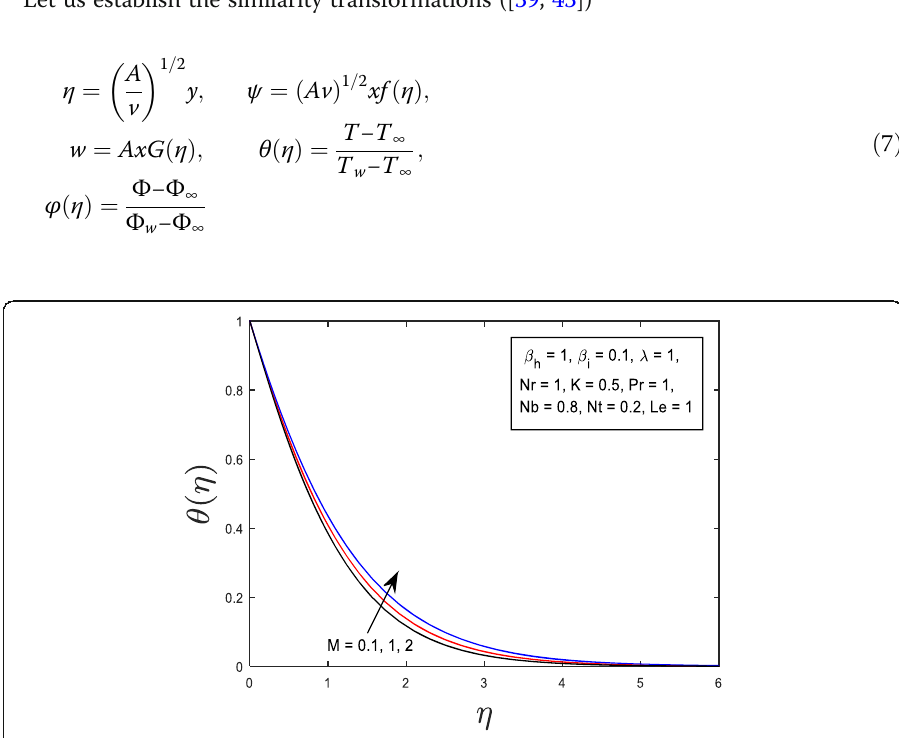
Fig. 4 Graph of temperature for various values of